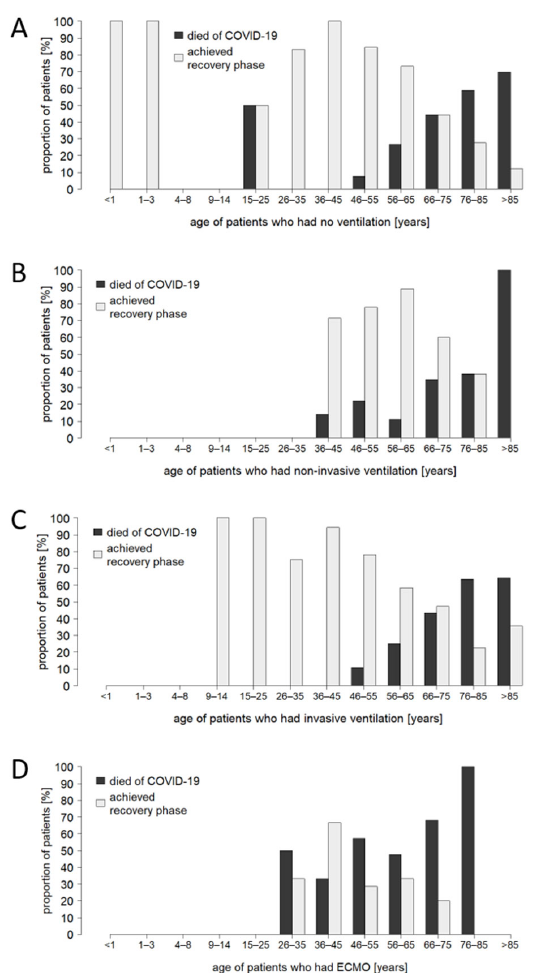
Figure A1. Distribution of age in recovered and deceased COVID-19 patients receiving intensive care. ( A ): Sub-cohort of non-ventilated patients ( n = 147), ( B ): sub-cohort of non-invasively ventilated patients ( n = 87), ( C ): sub-cohort of invasively ventilated patients ( n = 492), ( D ): sub-cohort of ECMO patients ( n = 114).